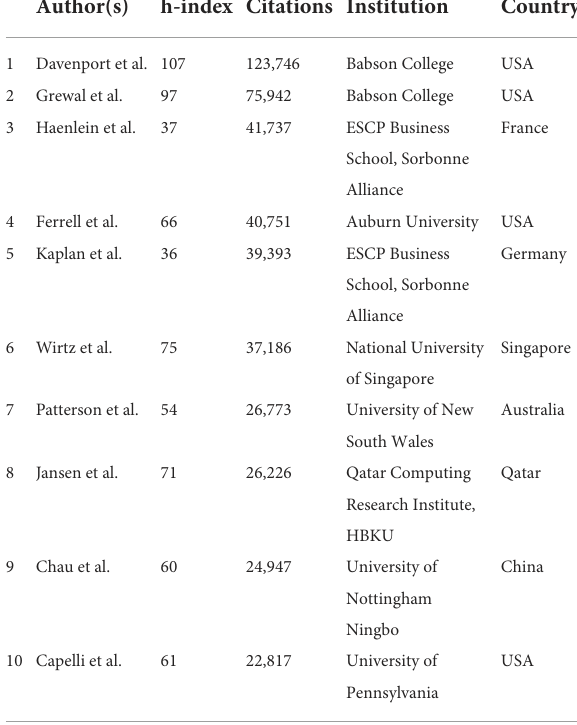
TABLE 6 Ten most influential authors by their total